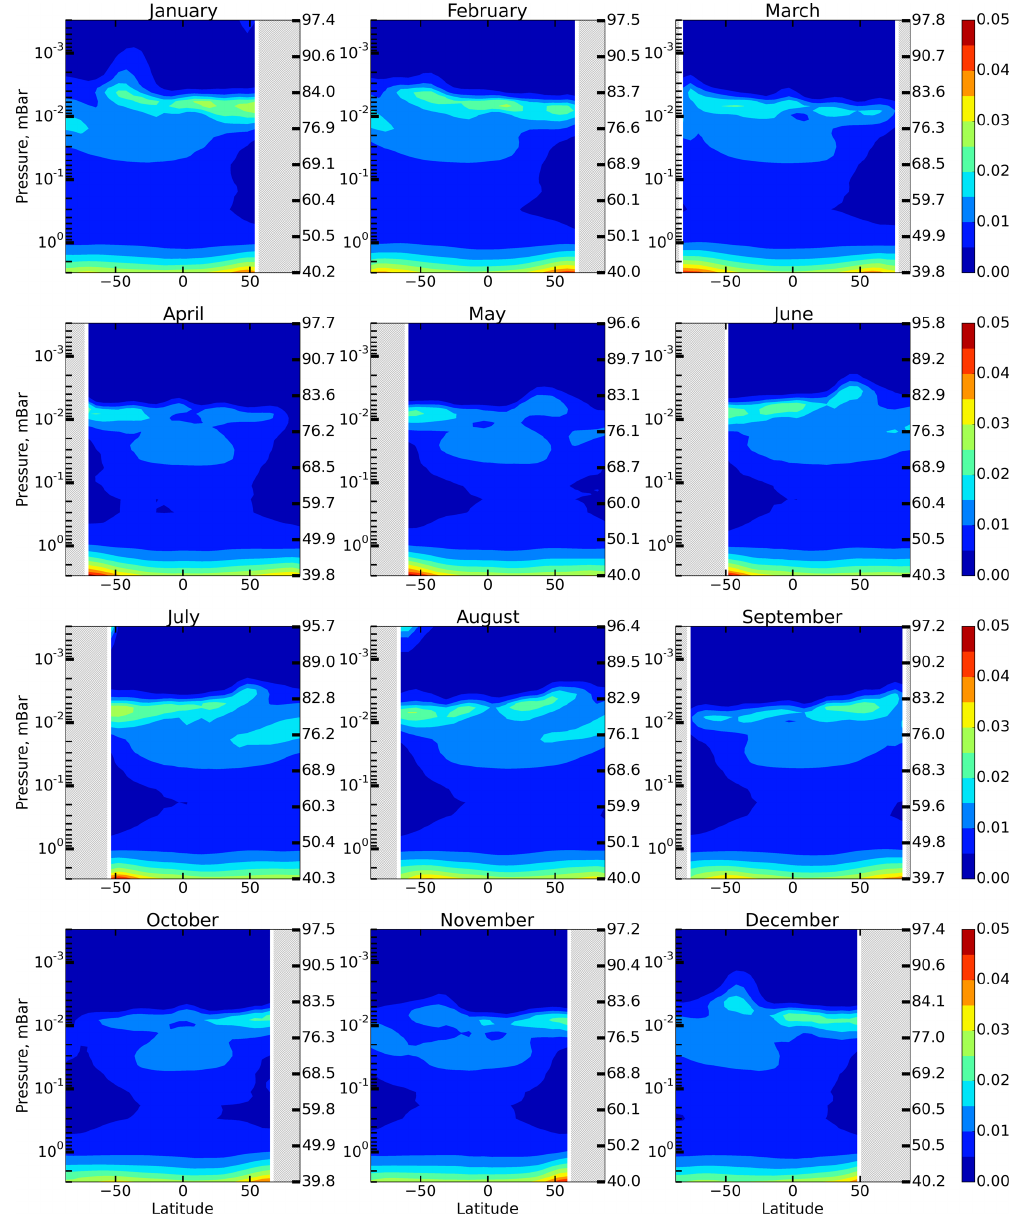
/P OH distributions. Figure 3. Daytime monthly averaged zonal mean P H 2 O OH By substituting this equation and Eq. (4) into Eq. (1) we ob- gle brackets denote monthly averaged zonal mean values). tain an expression relating OH, HO 2 , and O 3 : The gray area corresponds to χ > 85 ◦ . One can see that Eq. (6) is most accurate within the 50–76 km range and above 86 km, where | < F > − 1 | ≤ 1 %. The difference reaches 3–4 % in the region between 76 and 86 km. The altitude of this region has an annual variation with a max- imum deviation in the winter hemisphere. Below 50 km the value of < F > increases up to 1.2 at 40 km, thus below the stratopause Eq. (6) no longer describes the simultaneous Figure 1 shows height–latitude cross-sections of photochemical equilibrium of OH, HO 2 , and O 3 . Note (cid:104) F( OH , HO (cid:105) for each month (in this section an- 2 , O 3 )